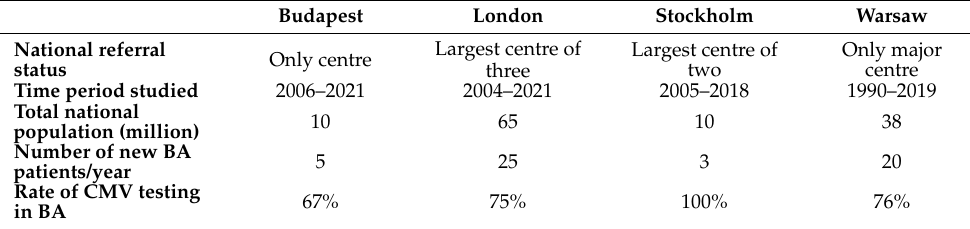
Table 1. Description of the four participating centres with regard to treatment of biliary